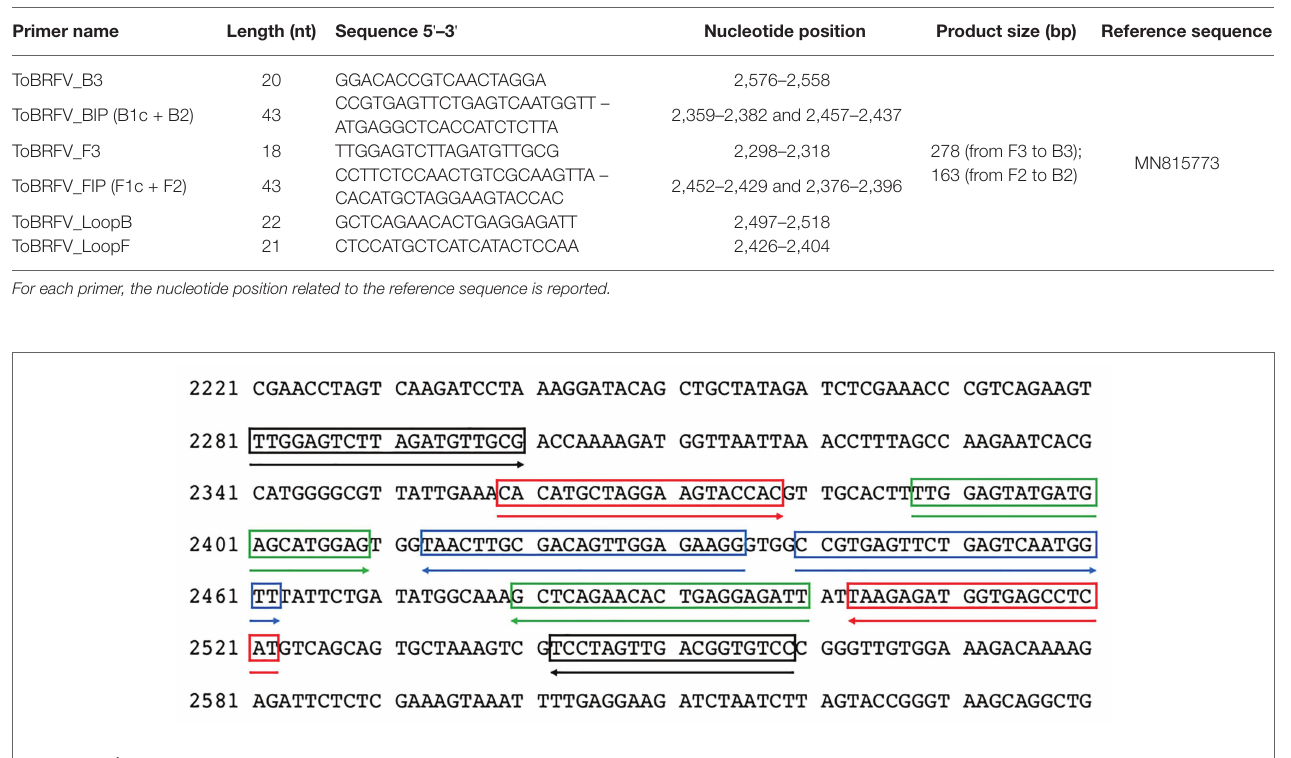
FIGURE 1 | Distribution of the LAMP primers on the nucleotide sequence of ToBRFV (GenBank Acc. Number MN815773). F3/B3 primers are highlighted in black, F2/B2 in red, LoopF/LoopB in green, and F1c/B1c in blue.